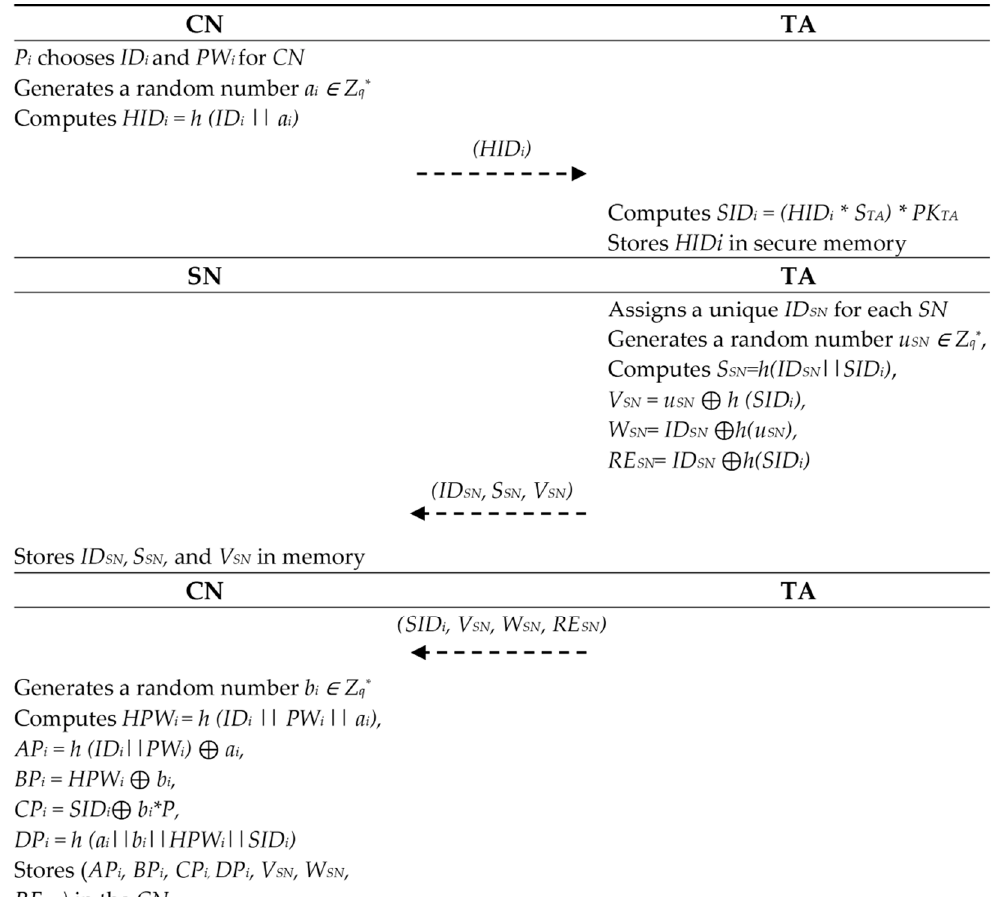
Figure 2. Registration phase.